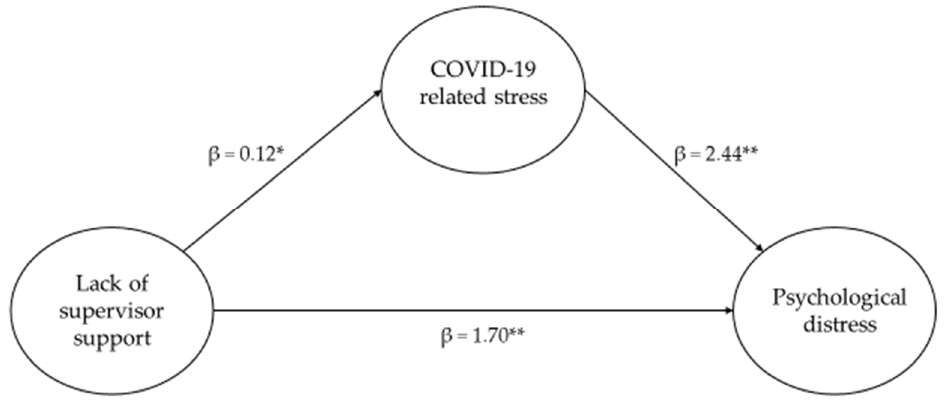
Figure 1. COVID-19-related post-traumatic stress as a mediator between lack of supervisor support and psychological distress. Note: N = 275, ** p < 0.01, * p < 0.05.